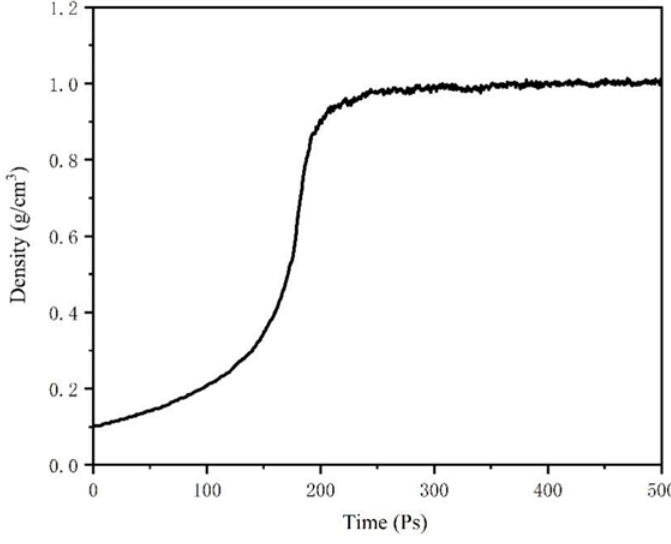
Figure 2. Density curve of asphalt model at 298.15 K in NPT simulation.